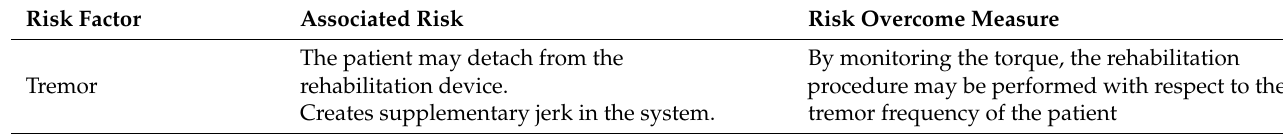
Figure 2. Arm position during rehabilitation and motion amplitudes ( a ); patient position during rehabilitation, experimental model ( b ).